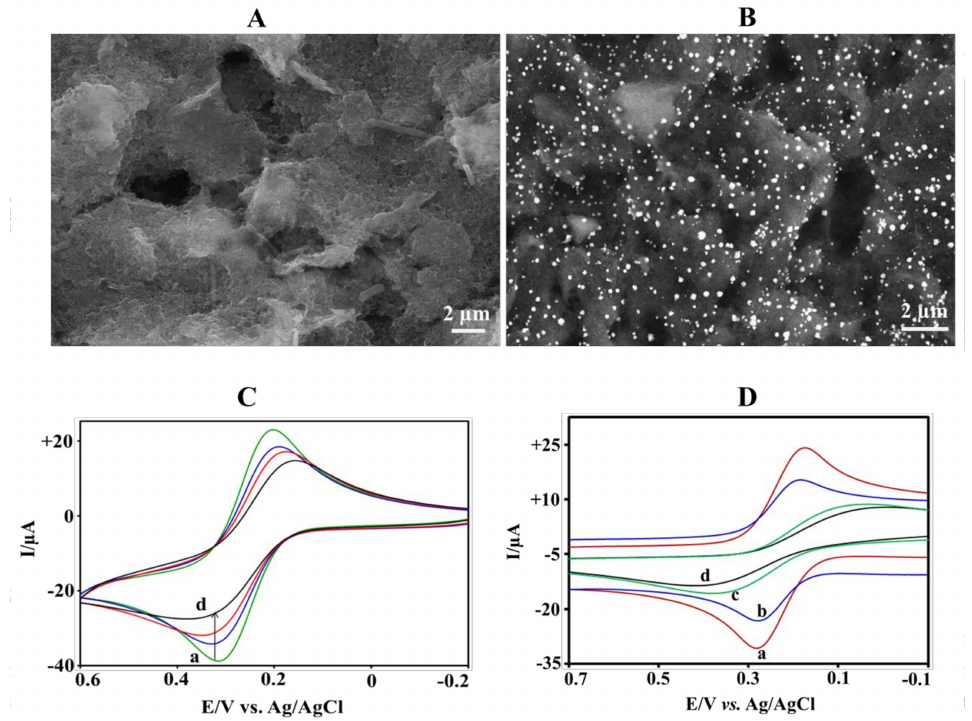
Figure 2. Scanning electron microscope (SEM) images of ( A ) bare screen printed electrodes (SPE) and ( B ) AuNPs-SPE. ( C ) Electrochemical response for (a) AuNPs-SPE, (b) anti-CRP-self-assembled monolayer (SAM)-AuNPs-SPE, (c) BSA-anti-CRP-SAM-AuNPs-SPE and (d) 1 nM CRP-anti-CRP-SAM-AuNPs-SPE in PBS solution containing 0.5 mM Fe(CN) 64 − . ( D ) Typical cyclic voltammetric responses of the AuNPs modified electrode (a) SAM-AuNPs-SPE and (b) anti-CRP-SAM-AuNPs-SPE, and without AuNPs electrode (c) bare SPE, and (d) anti-CRP-SPE for 1 nM CRP in PBS containing 0.5 mM Fe(CN) 64 − at a scan rate of 50 mV s − 1